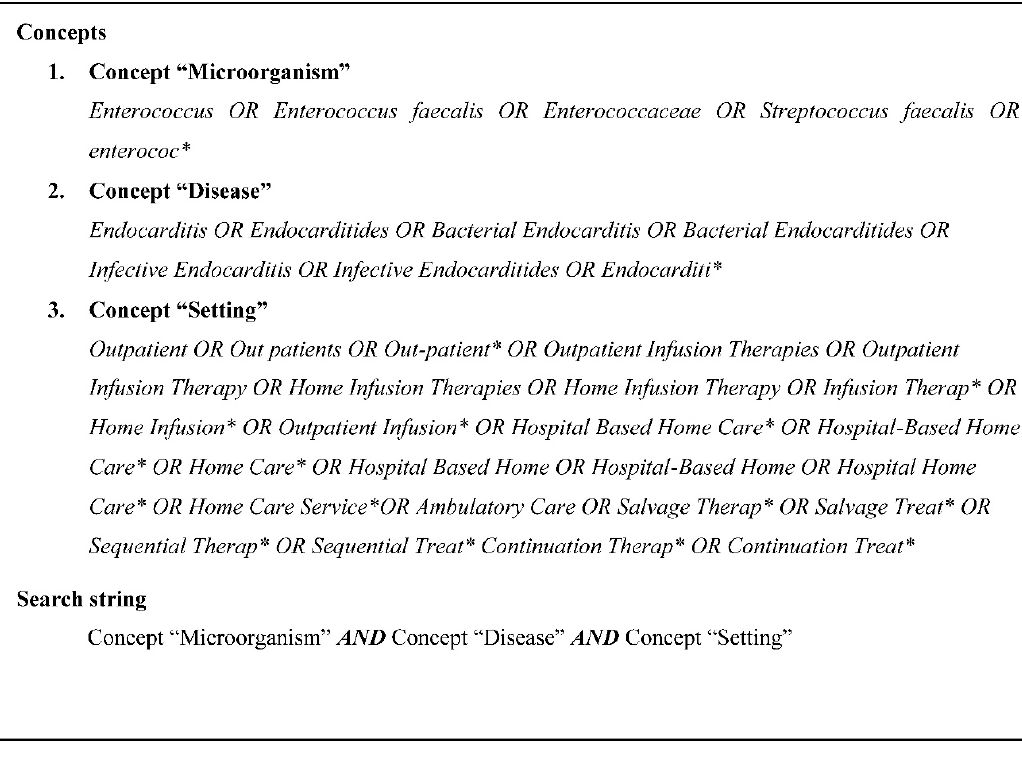
Figure 2. Search strategy.